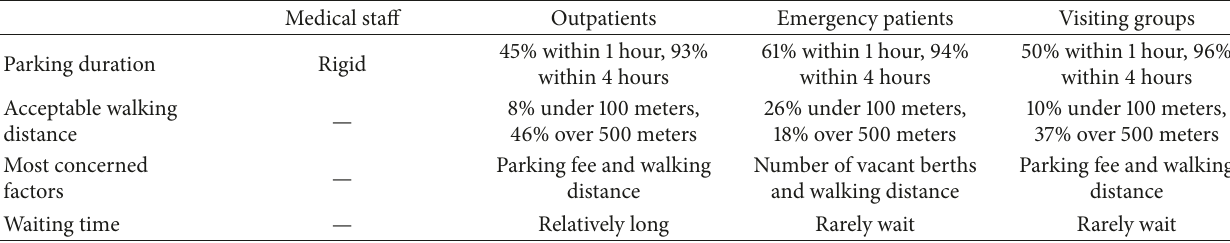
Table 2: Comparison of parking behaviors of four